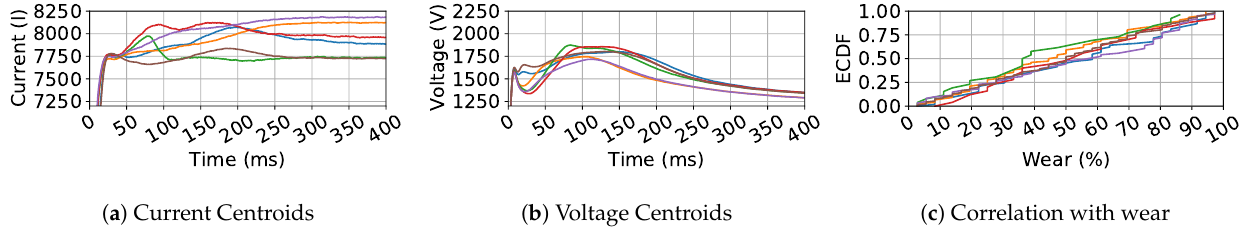
Figure 13. Clusters representation Working Station 1 Clamp 1 ws a